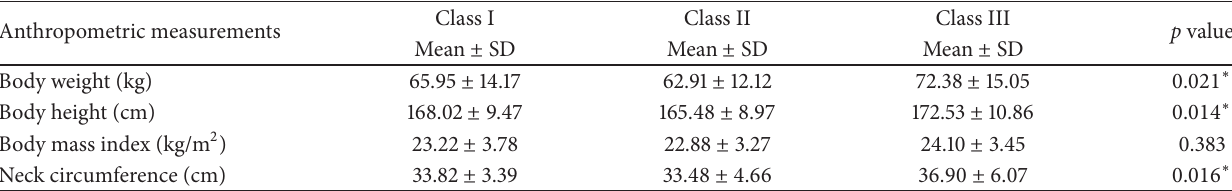
Table 4: Anthropometric data in the different skeletal classes. ∗ refers to significant differences between class II and class III. Anthropometric